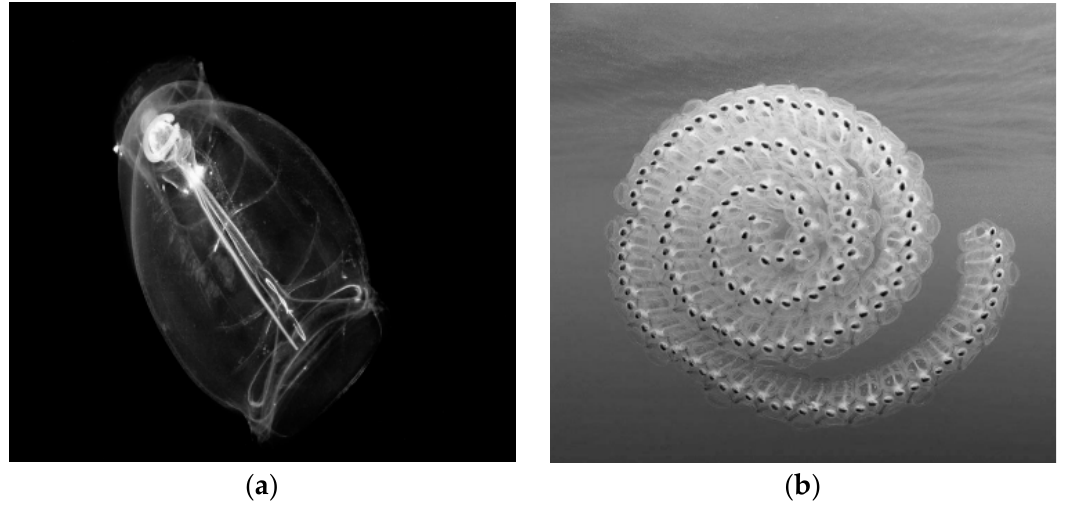
Figure 6. Single salp ( a ) and salp chain ( b ).